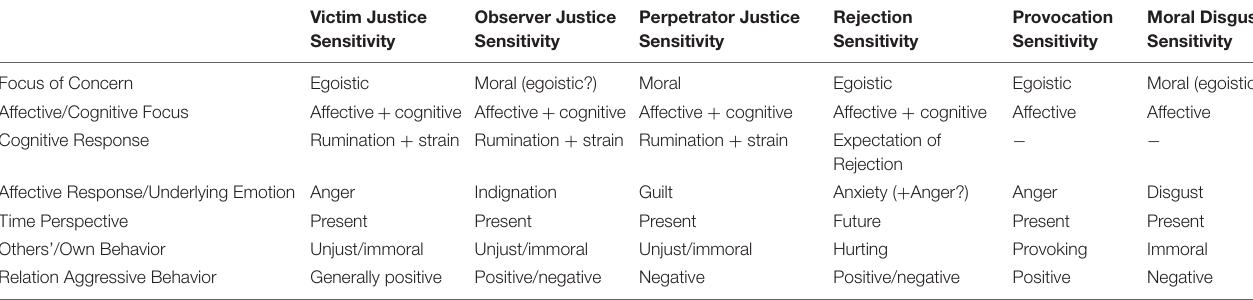
TABLE 4 | Overview over differences and similarities between sensitivity